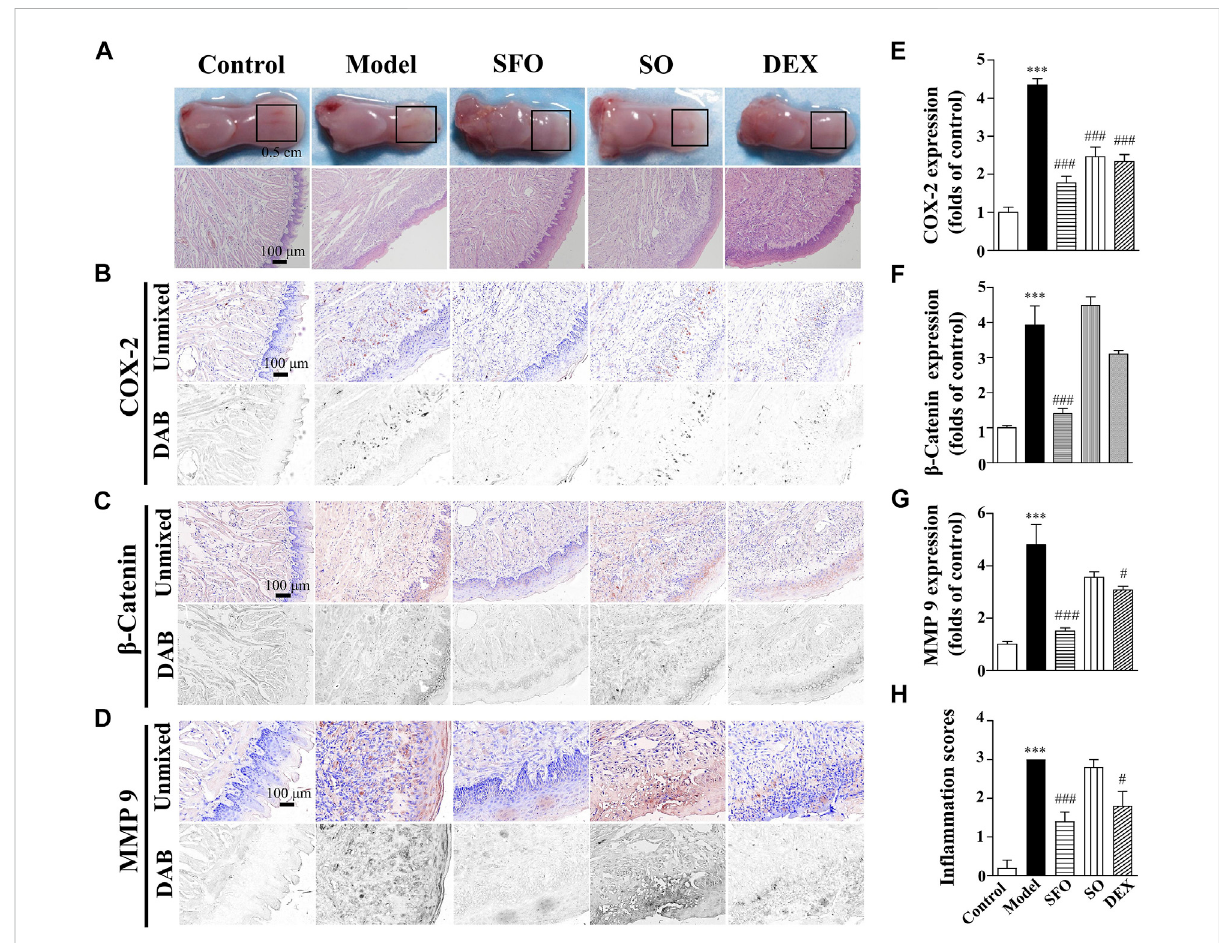
FIGURE 2 Effect and repair mechanism of ShengFu oil in tongue of glacial acetic acid-burned mice. (A) General view of the tongue samples, and H&E staining of tongue sections in control, model, ShengFu oil (SFO), dexamethasone (DEX), and sesame oil (SO) groups. Representative (B – D) and summary (E – G) of histochemistry analysis of expression of COX-2, β -catenin and MMP-9, respectively. (H) The in fl ammation scores of the tongue samples in the H&E-stained images. Scale bar, 100 µm. Compared with the control group, ppp , p < 0.001. Compared with the model group, #, p < 0.05, ###, p <